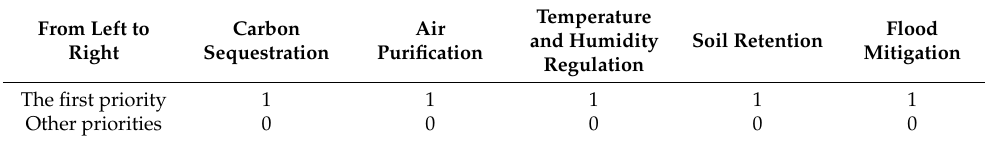
Table 2. Binary code table.